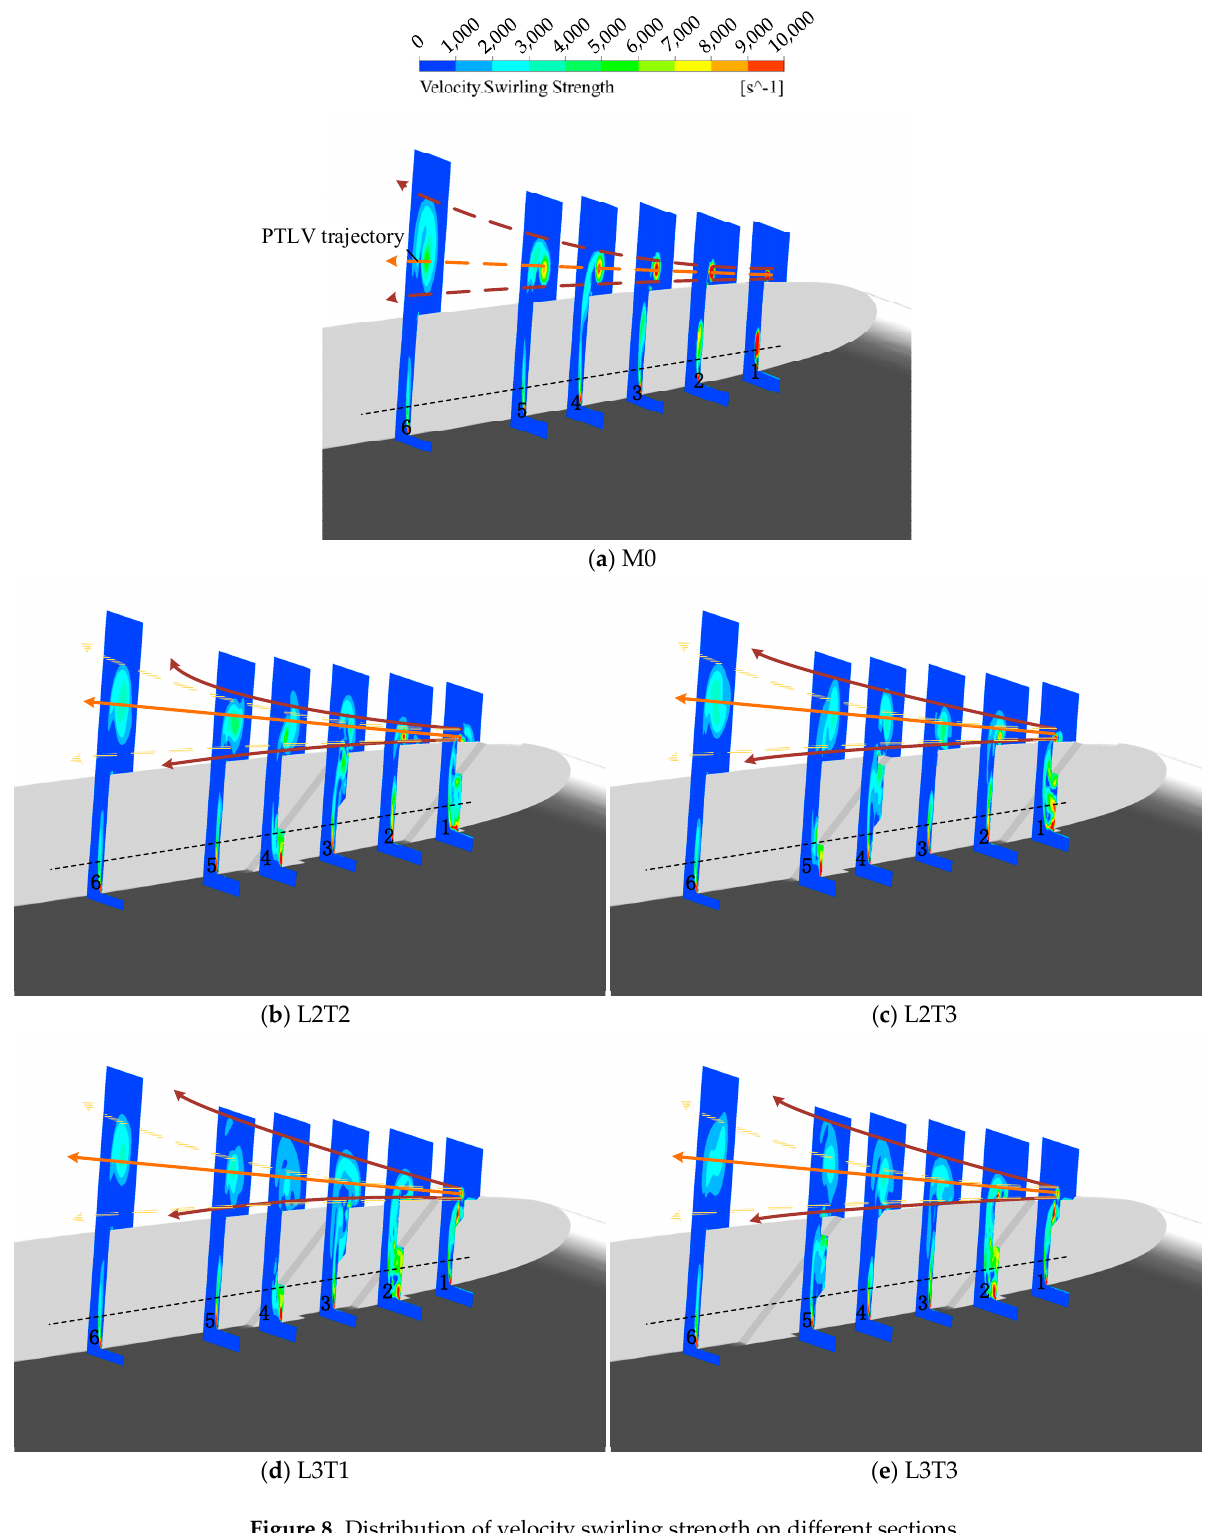
Figure 8. Distribution of velocity swirling strength on different sections. Comparing M0 with the optimally designed configurations, the presence of the parallel grooves helps the development of the GLV, as shown in plane 4 of L2T2 and L2T3, and the swirling strength of the GLV is enhanced to some extent. With the backward movement of the groove, as shown in plane 5 of L2T3, the swirling strength of GLV is